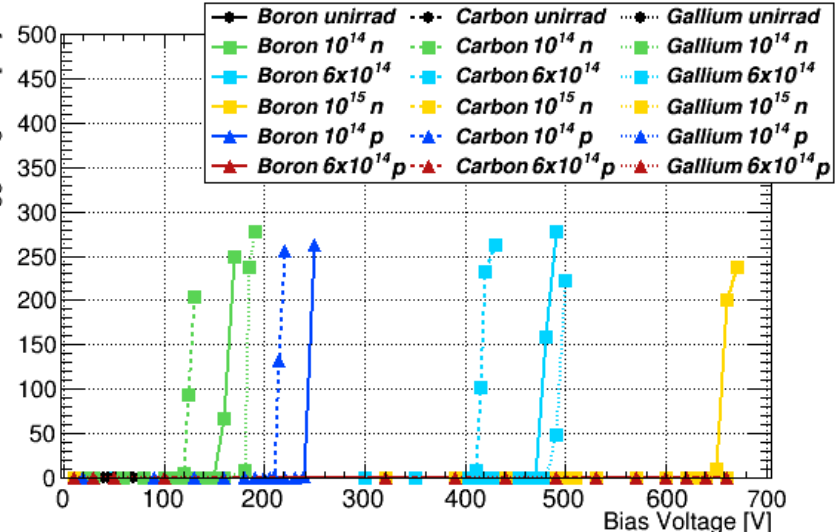
Figure 9. Auto-triggering rate as a function of the bias voltage for CNM LGADs before and after irradiation up to a fluence of 10 15 n eq /cm 2 at −